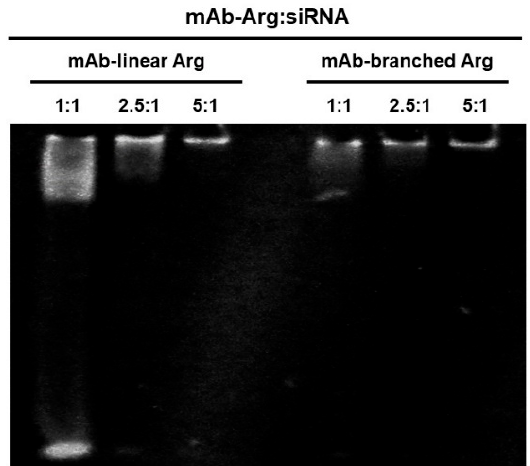
Figure 3. Gel shift assay. Anti-CD63 mAb-linear or -branched Arg:siRNA complexes were obtained by mixing anti-CD63 mAb bound to linear- or branched Arg linker and siRNA at various molar ratios. The lower band of the lane of mAb-linear Arg at the ratio of 1:1 indicates unbound siRNAs. (Figure S3).